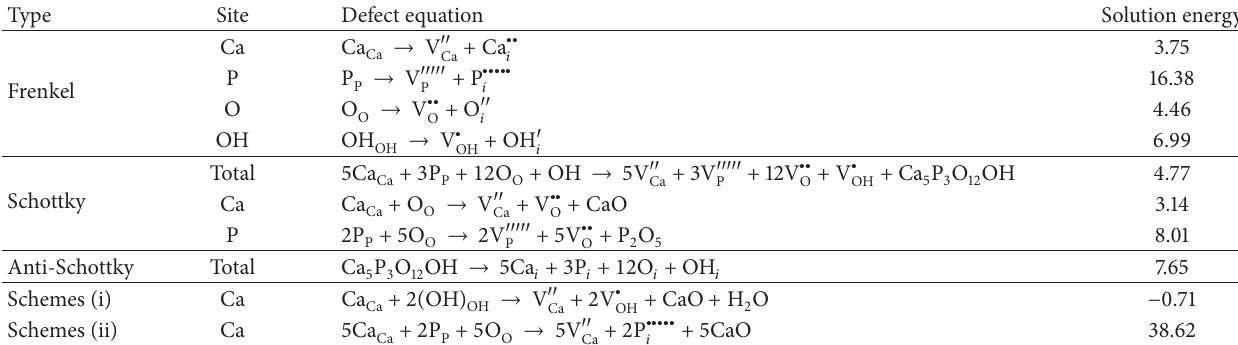
Table 4: Solution energy of intrinsic disorder in hydroxyapatite